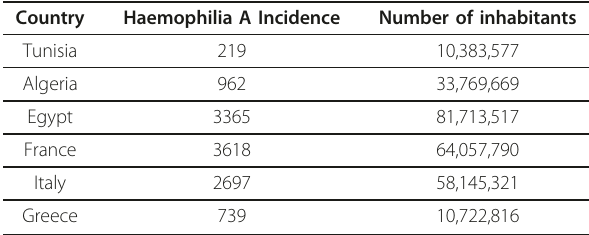
Table 1 The Tunisian hemophilia A incidence in comparison to that of other Mediterranean countries according the World Federation of Hemophilia Report on the ANNUAL GLOBAL SURVEY 2007